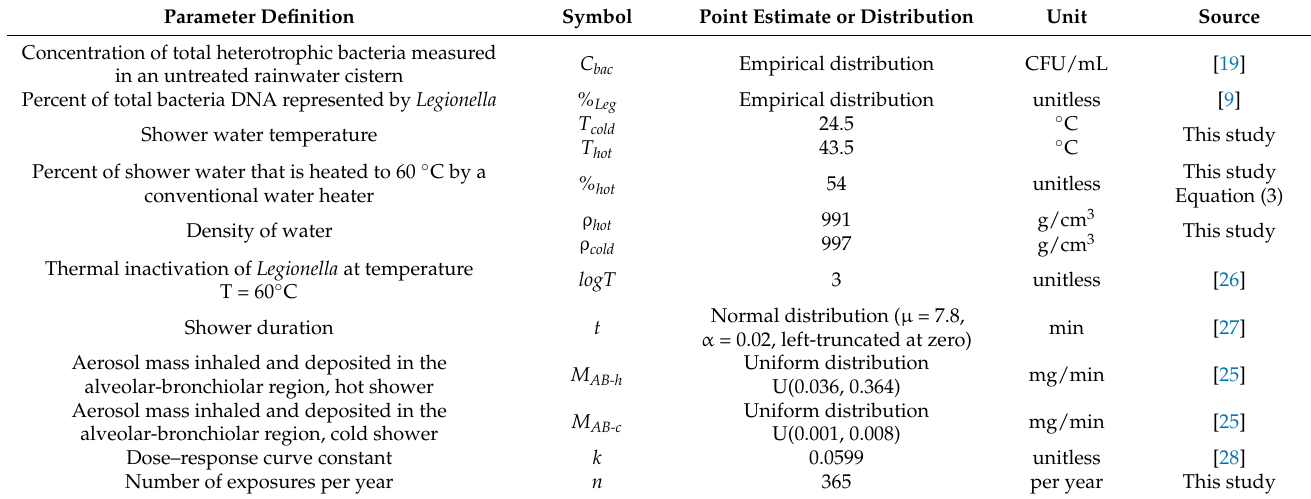
Table 1. Input parameters for the Monte Carlo simulation to calculate daily and annual risk of Legionella